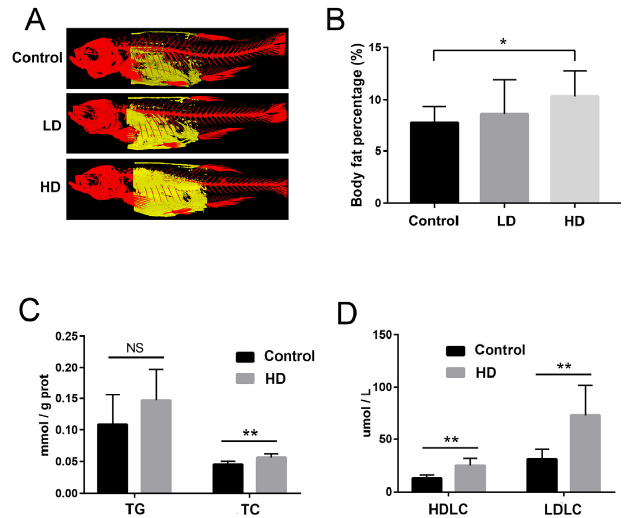
Figure 2. The reconstructed image of body fat revealed by 3D micro-CT, and comparative evaluation of biochemical indexes in zebrafish. ( A ) Typical images of trunk fat (yellow) of fish in each group